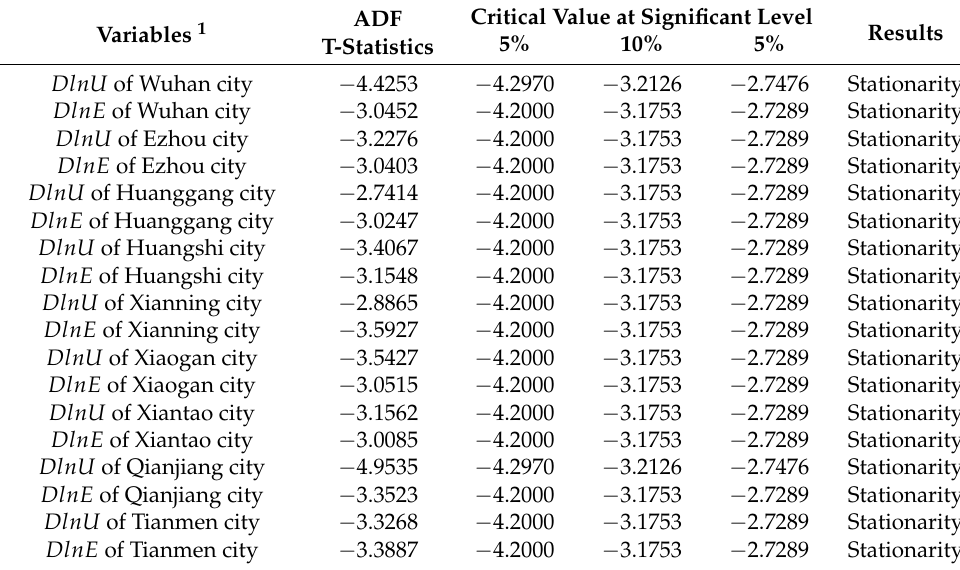
Table 5. The stability test results of urbanization and ecological